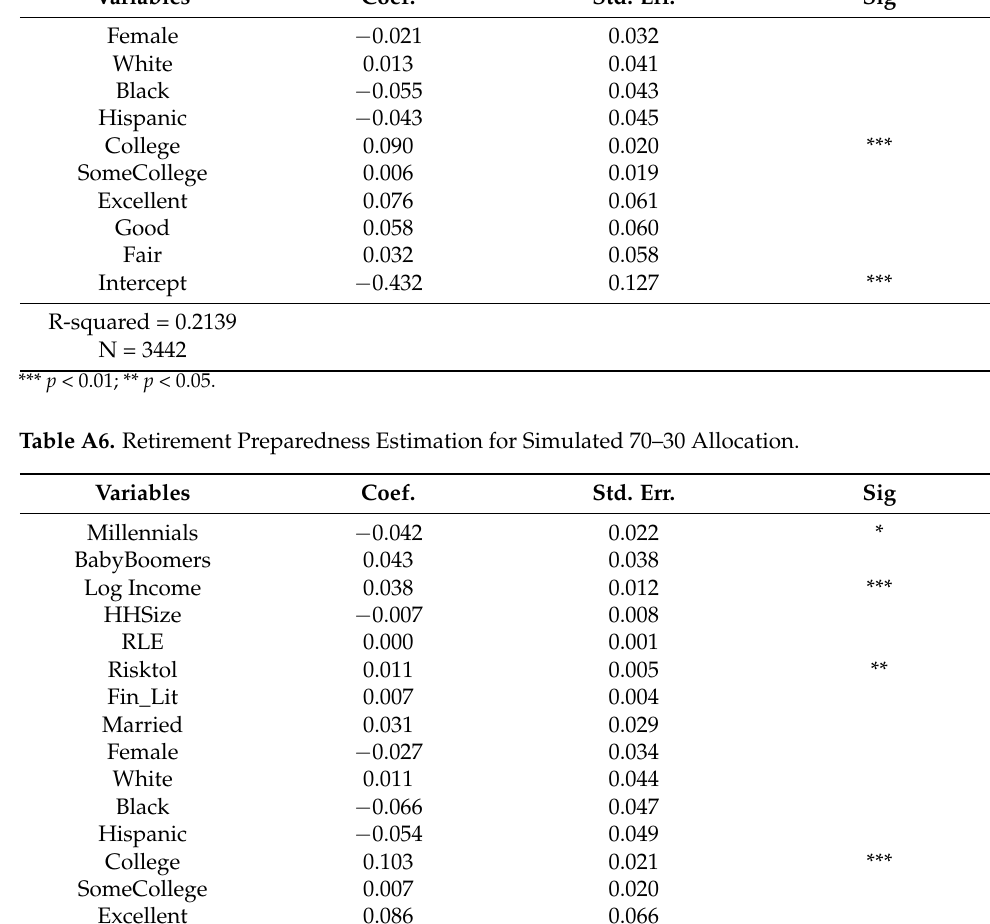
Table A5. Cont . Variables Coef.